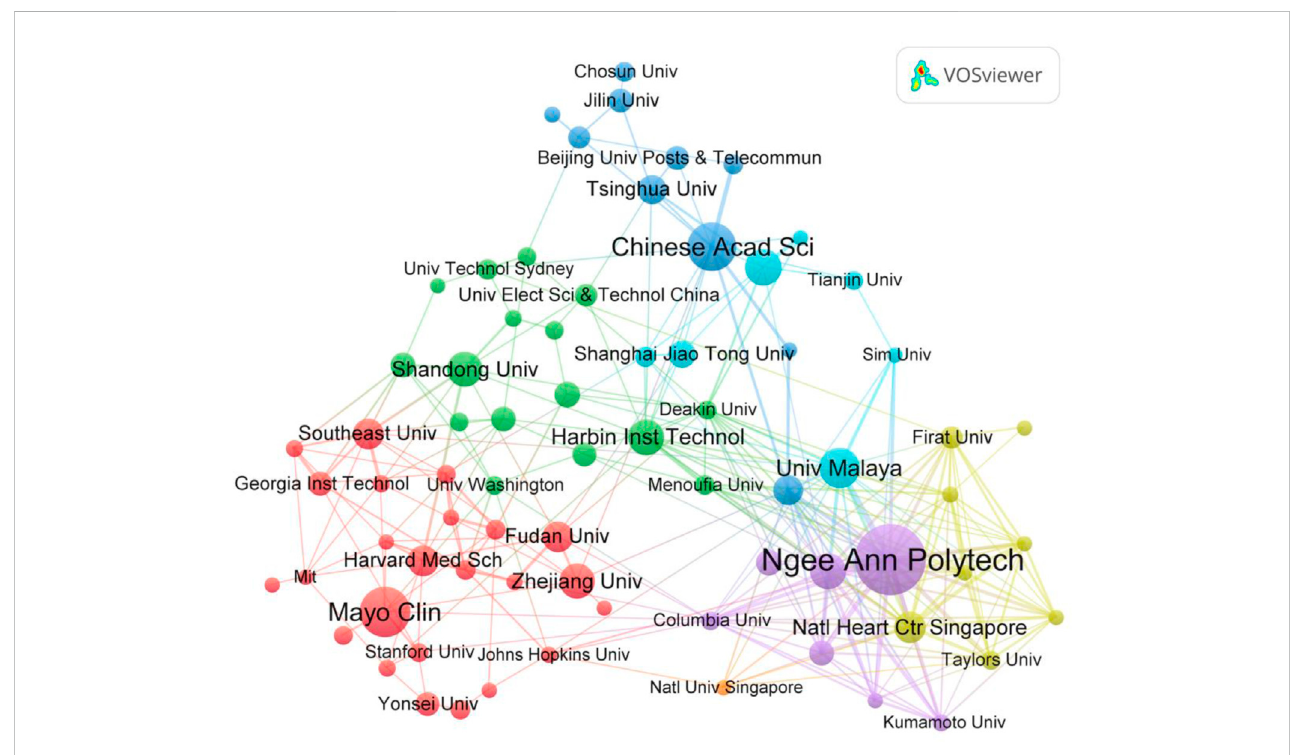
FIGURE 4 The visualization map of international co-authoring institutions network using VOSviewer.